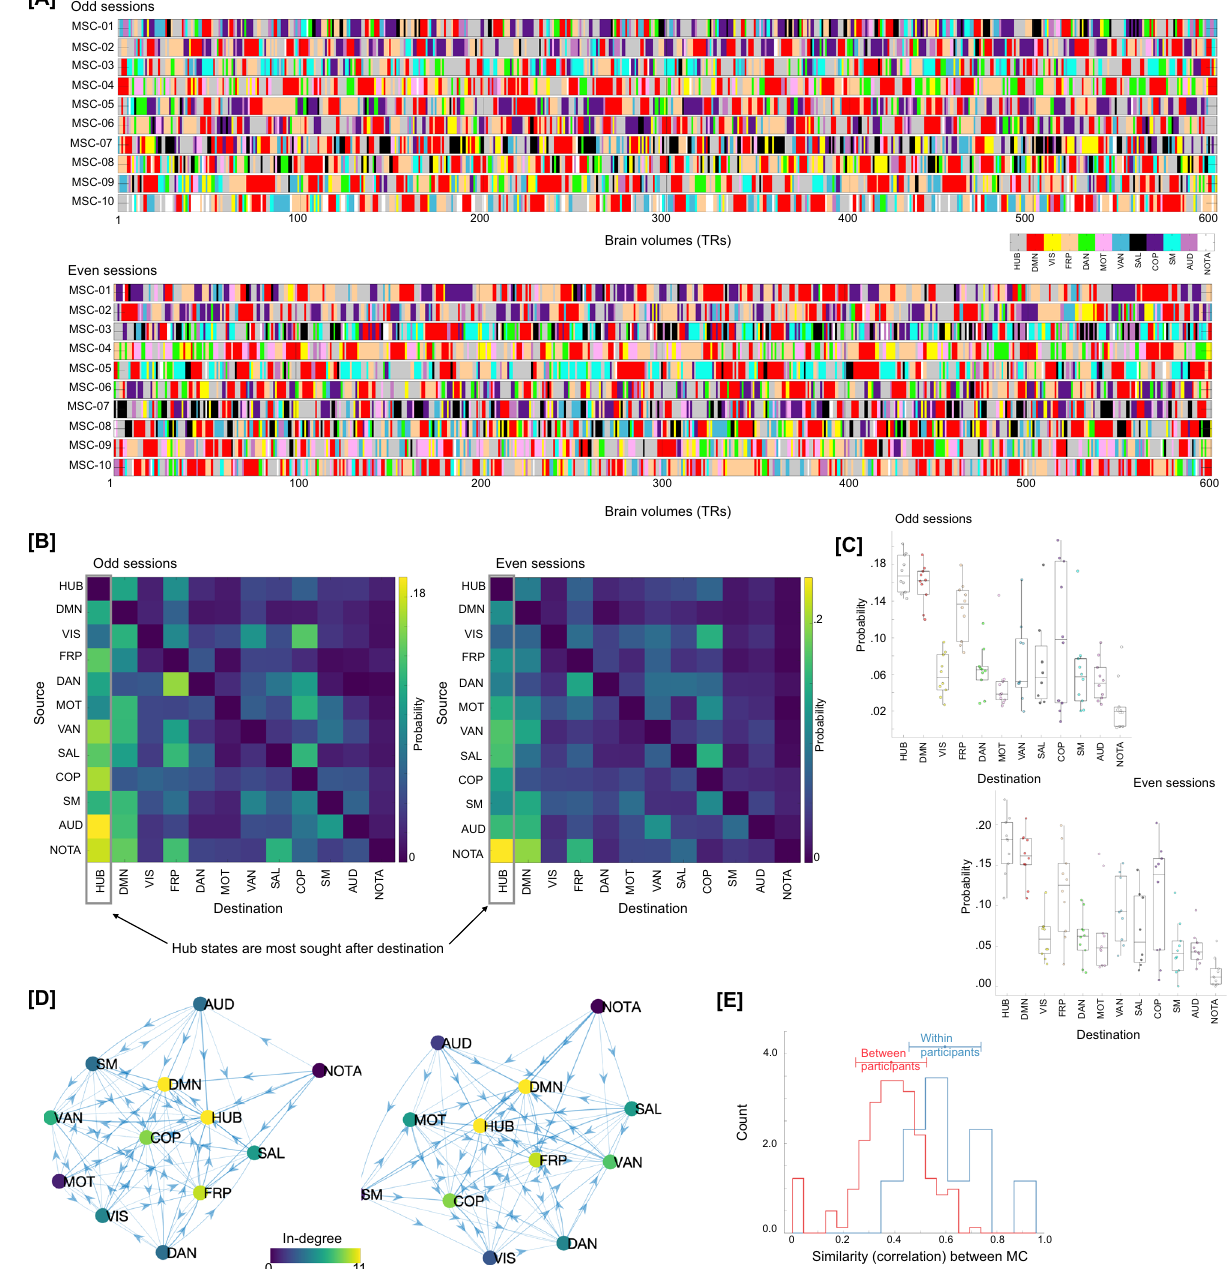
Fig. 6 | Traversal in the temporal domain at the single frame level. A Depicts transitions in brain activation over time frames in terms of dominant individual- speci fi c RSN (or hub-like state). Each time frame (or TR) was labeled from the Mapper-generated shape-graphs by propagating the RSN-based annotation from eachgraphnodetothetimeframesrepresentedbythatnode.InadditiontoRSNs,a new label representing hub-nodes was also generated. As evident, hub state was often visited by participants across both data splits. Only showing a subset of timeframes( fi rst600frames)foreachparticipantforeaseofviewing. B Adiscrete- time Markov chain was estimated using RSN-based labels for each participant and datasplit.Whileestimatingtransitionprobabilities,transitionsduetodiscardingof motion affected frames and stitching sessions were rejected. Here, we present transitionprobabilitymatrixaveragedoverall10MSCparticipants.Diagonalswere